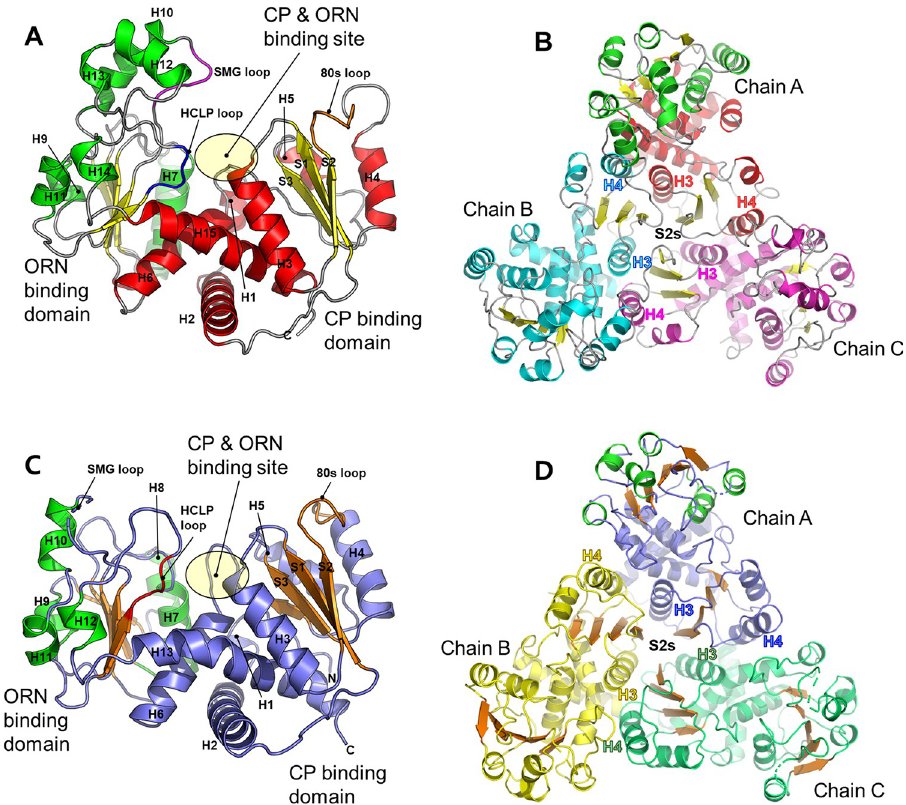
Fig 3. Monomeric and oligomeric structures of Ps _cOTC and Ps _aOTC from Psychrobacter sp. PAMC 21119. (A, B) Monomeric Ps _cOTC (red, A) and its trimer (cyan and magenta, B) are shown in cartoon representation. (C, D) Monomeric Ps _aOTC (purple-blue, C) and its trimer (yellow and green, D) are also shown in cartoon representation. The strands are yellow for the Ps _cOTC and brown for the Ps _aOTC. The CP and ORN binding sites are highlighted by yellow circles at the two-domain